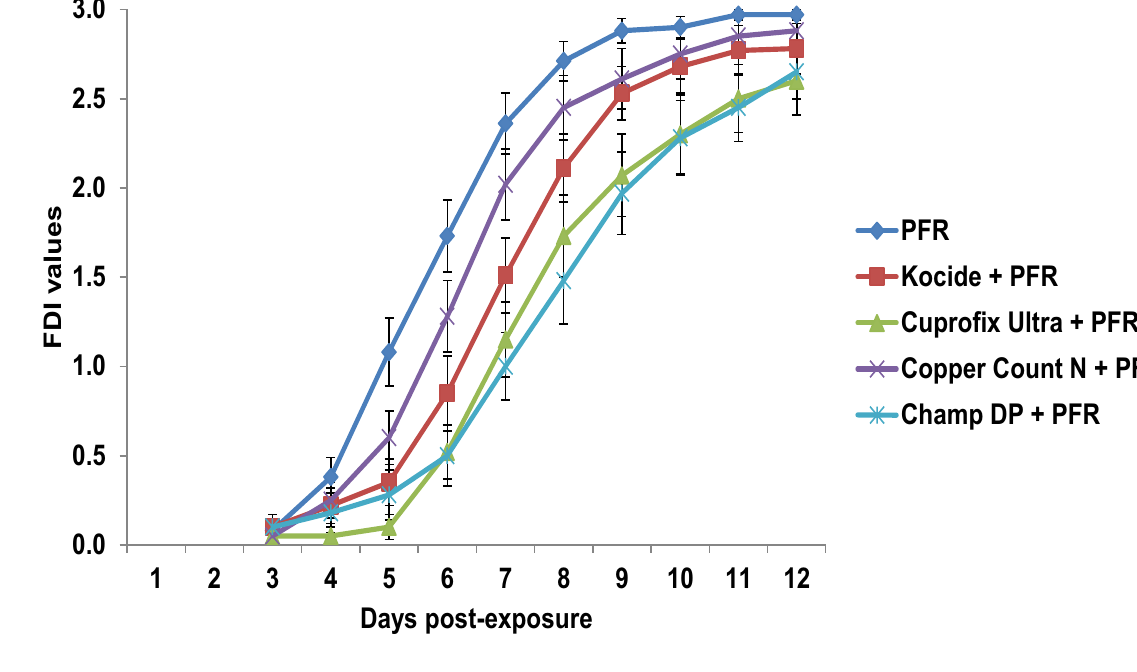
Figure 6. Progression of Isaria fumosorosea (PFR) blastospores applied post-application of fungicides on leaves exposed to D. citri in laboratory tests assessed using a fungal development index (FDI) [27]. Data are mean ± SEM of three tests (10 replicates per test). Control (water only) mortality was 7% after 7 days and 23% 12 days